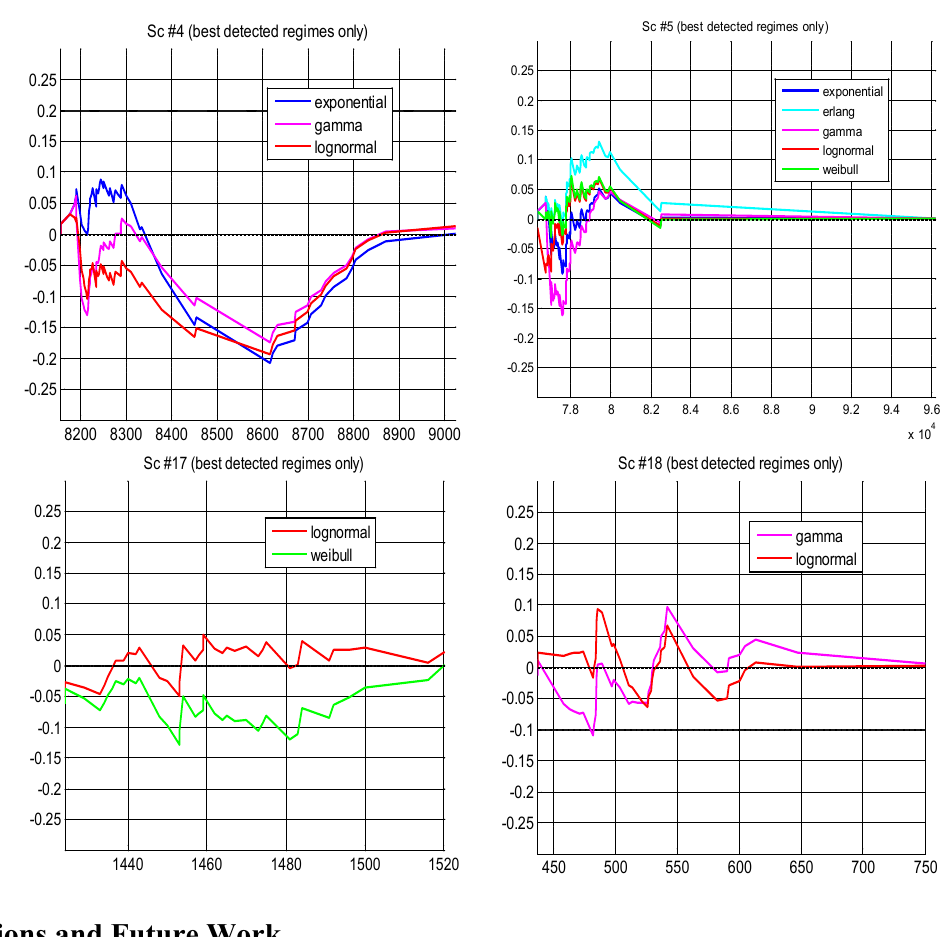
Figure 9. PDGs for those regimes obtained by the confidence interval method where more than one parametrical model explain successfully the data obtaining their best p